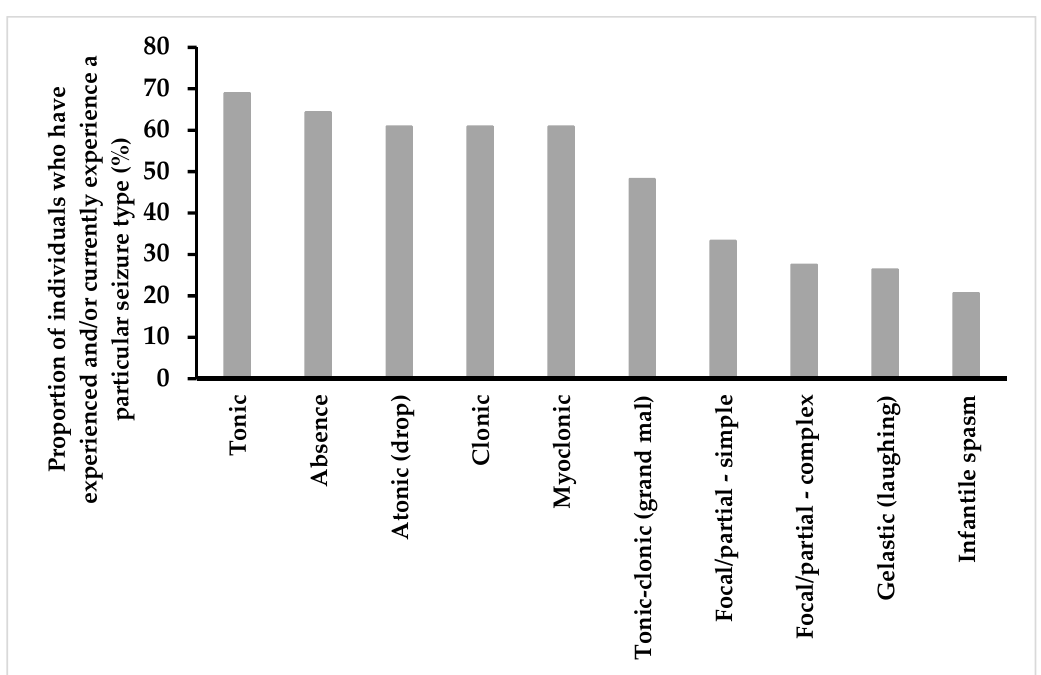
Figure 4. Proportion of individuals who have experienced different seizure types.